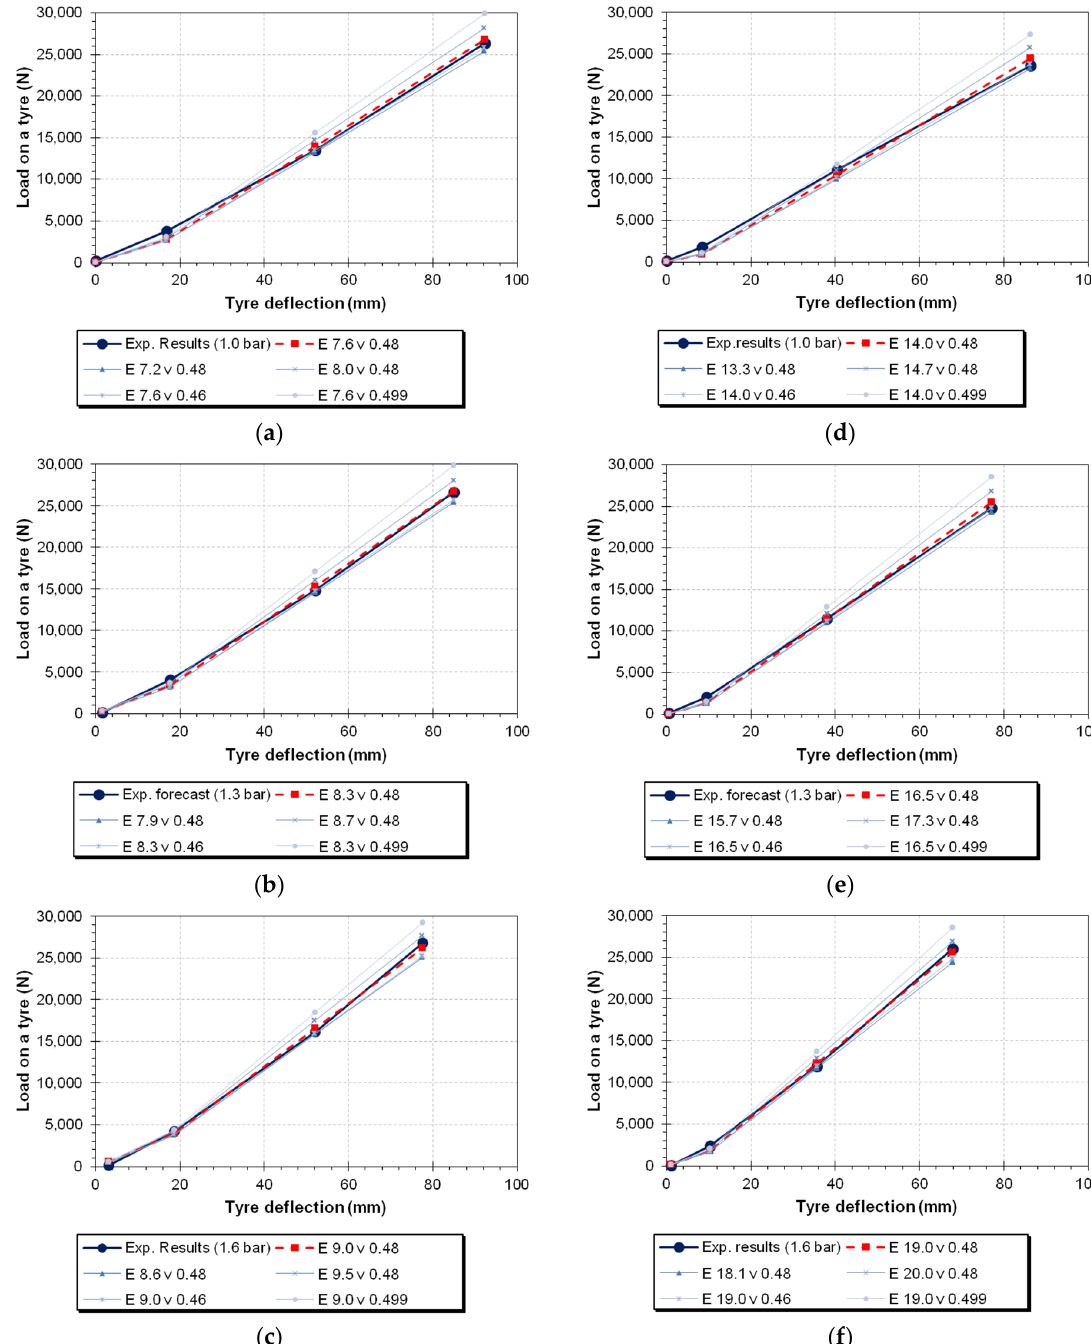
Figure 7. FEM load–deflection curves with different equivalent Young’s moduli and Poisson’s ratios of the rubber in comparison with the experimental tyre curves for 420/85 R24 ( a – c ) and 460/85 R34 ( d – f ): ( a , d ) tyre inflation pressure of 1.0 bar; ( b , e ) tyre inflation pressure of 1.3 bar; ( c , f ) tyre inflation pressure of 1.6